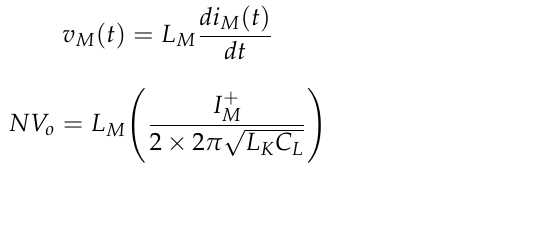
Figure 12. Equivalent circuit of resonance circuit for each state: ( a ) equivalent circuit of resonant circuit in state 1; ( b ) equivalent circuit of resonant circuit in state 2; ( c ) equivalent circuit of resonant circuit in state 3; ( d ) equivalent circuit of resonant circuit in state 4; ( e ) equivalent circuit of resonant circuit in state 5; ( f ) equivalent circuit of resonant circuit in state 6.